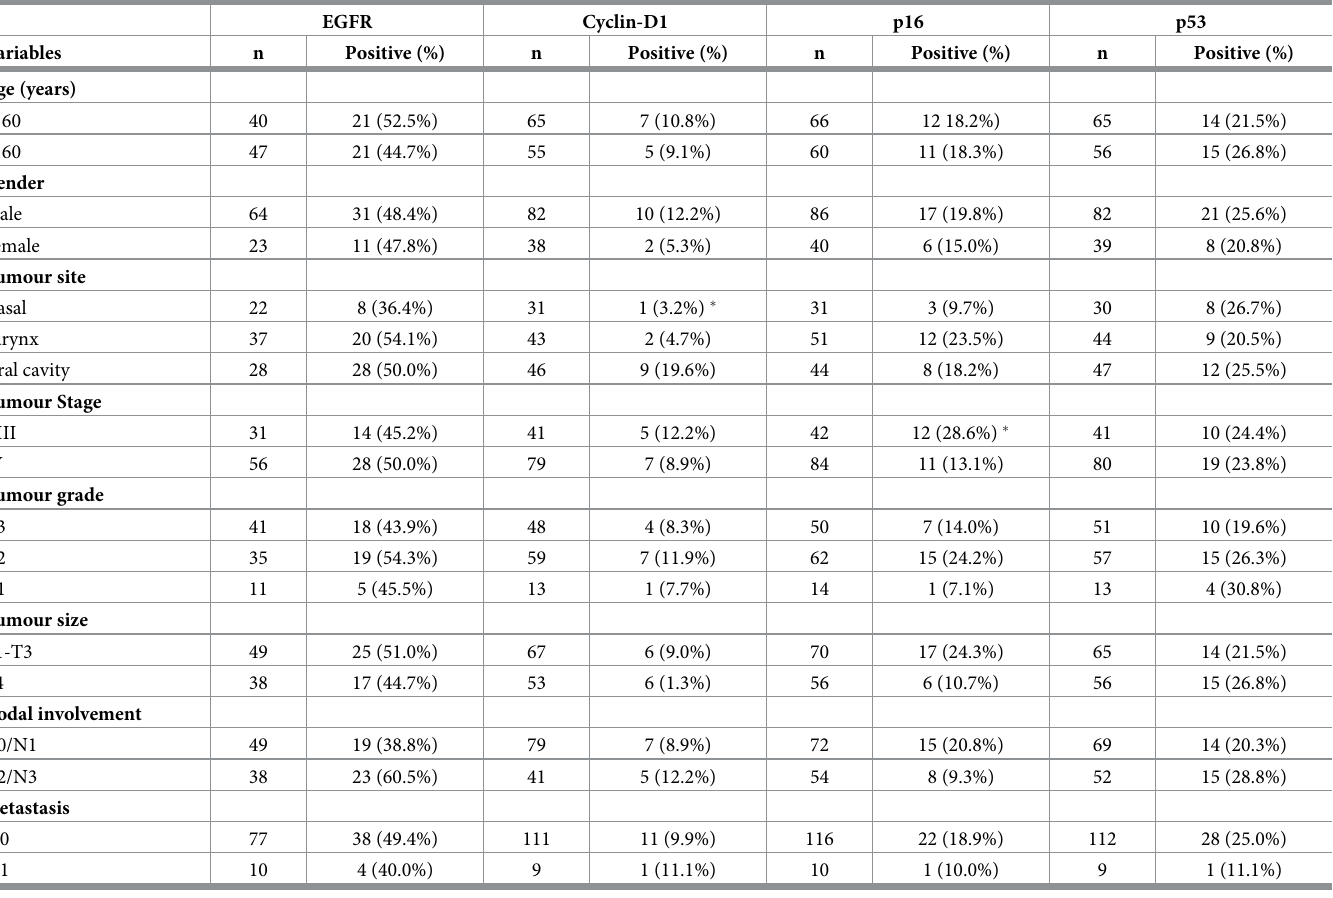
Table 3. Association between age, gender, and clinico-pathological features and the expression of molecular markers among non-oropharyngeal HNSCC patients.